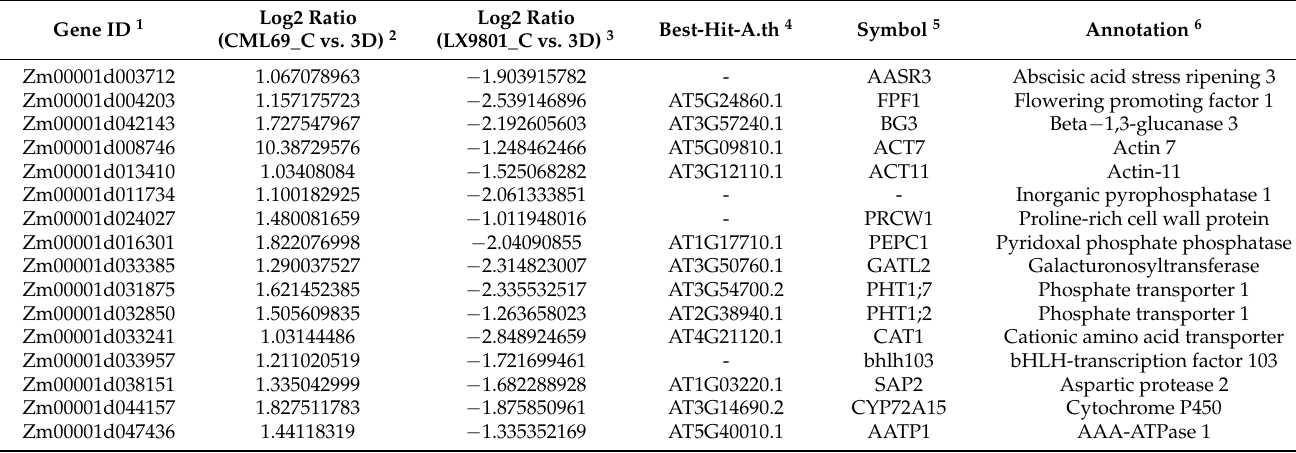
Table 4. Sixteen drought-responsive DEGs upregulated in CML69 but downregulated in LX9801 at 3D drought stress. Gene ID